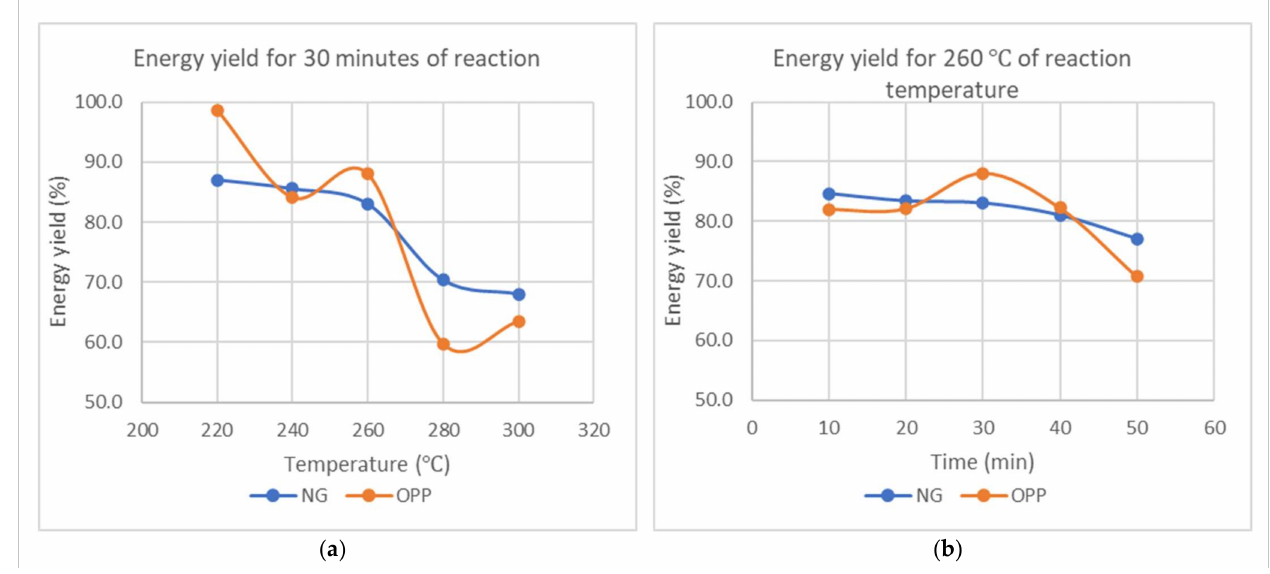
Figure 7. Energy yield ( a ) against temperature at constant reaction time of 30 min and ( b ) against reaction time at constant temperature of 260 ◦ C.